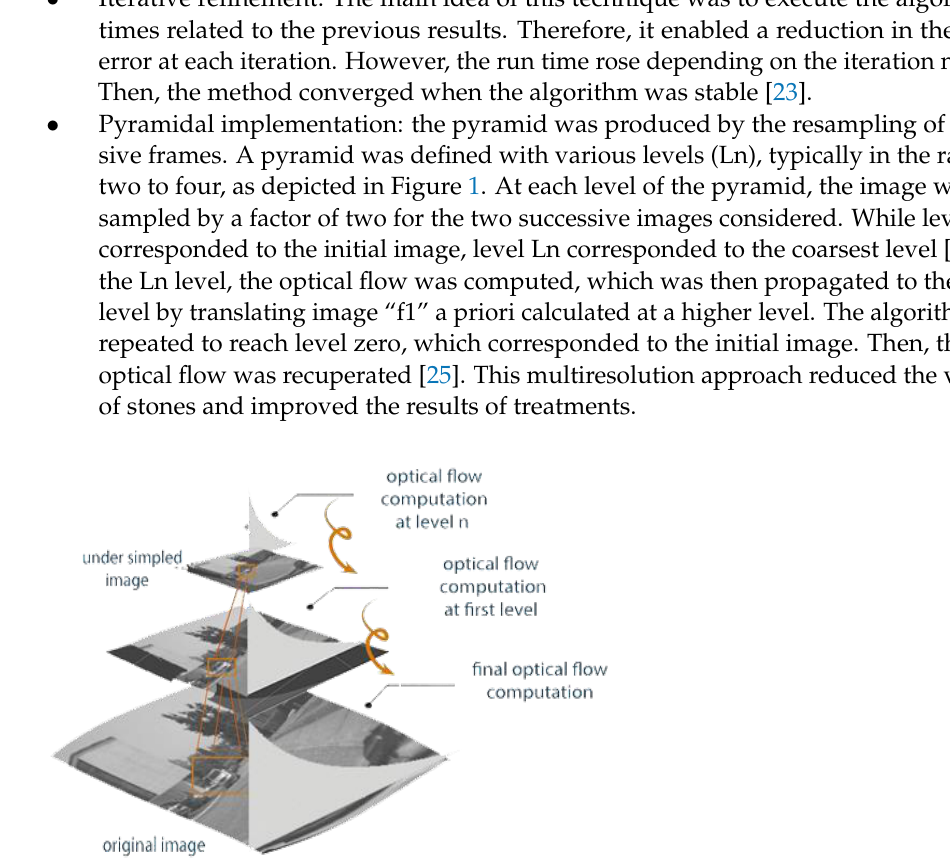
Figure 1. Iterative pyramidal refinement.